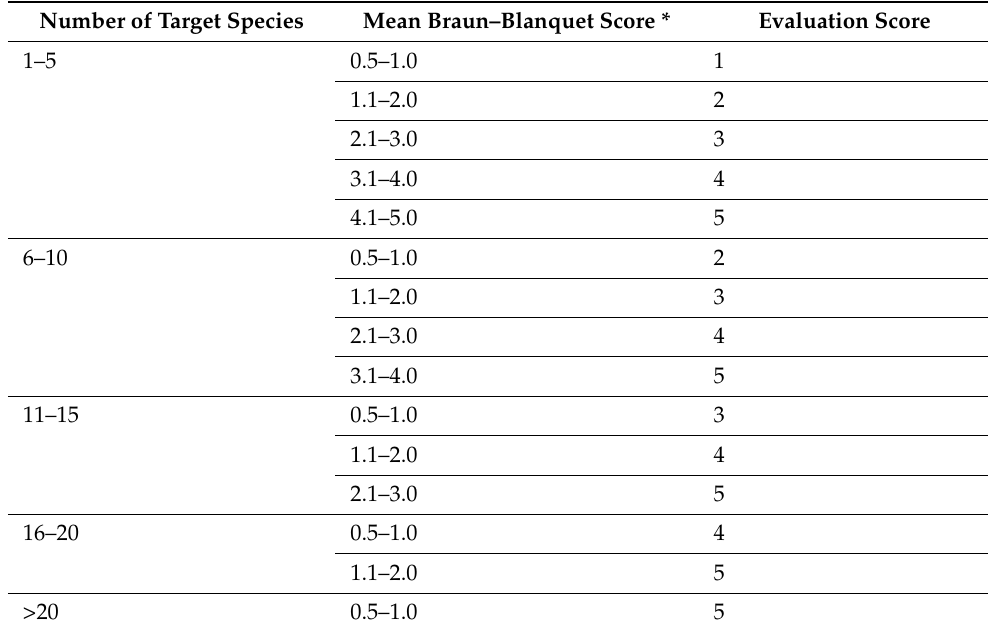
Table 5. Genetic site evaluation by number of target species and their cover-abundance (adapted from